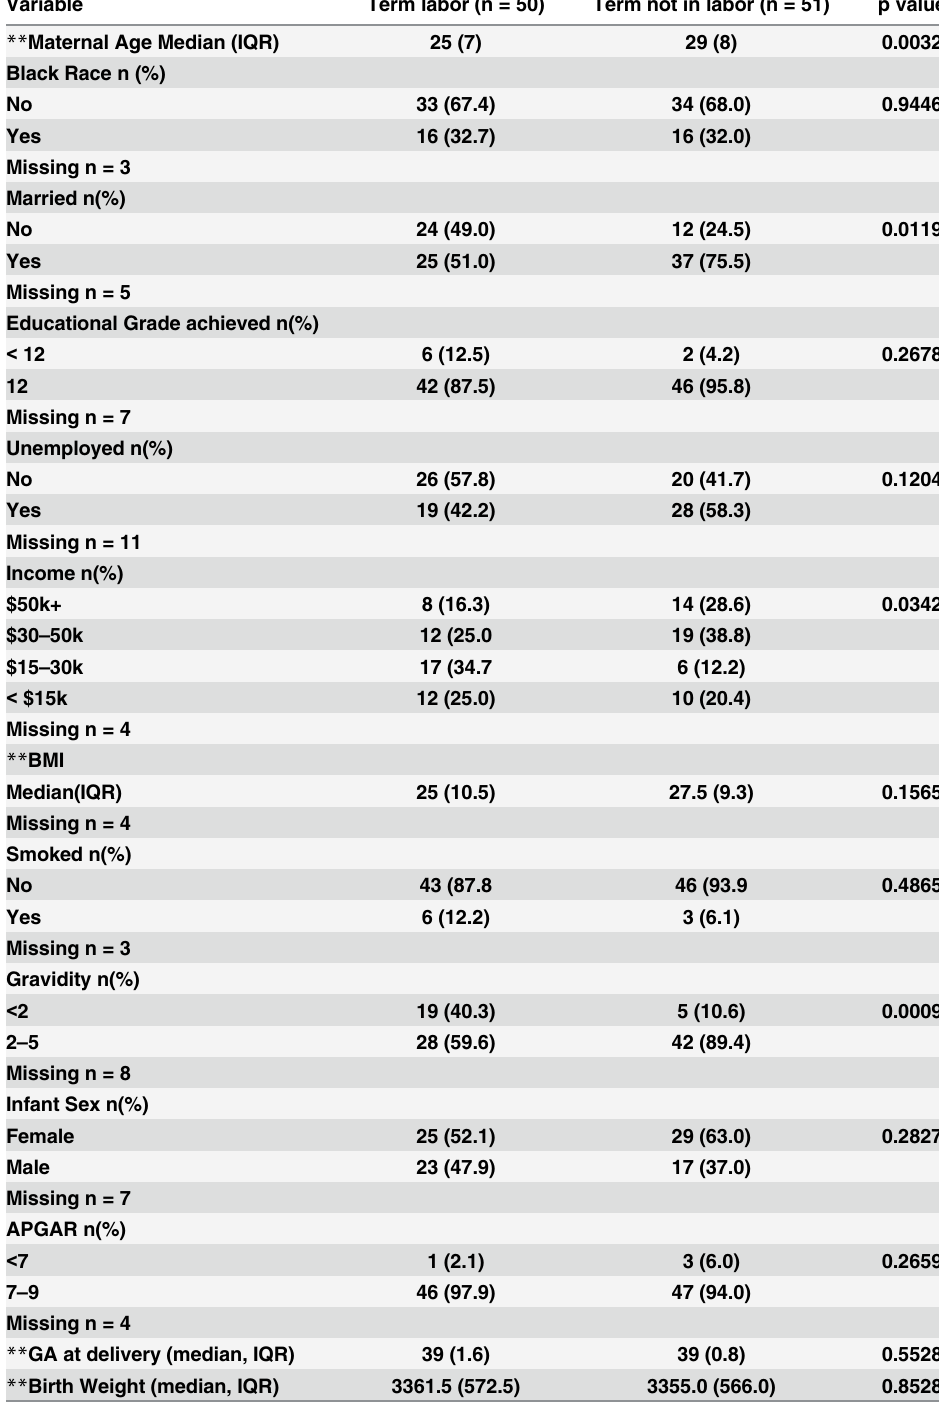
Table 1. Demographic, obstetric and clinical characteristics of studied patients according to the preg- nancy